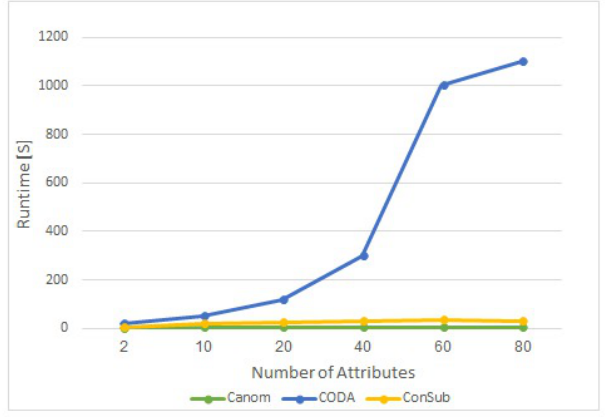
Figure 8. Variations in runtime according to the different number of attributes for each of the tested